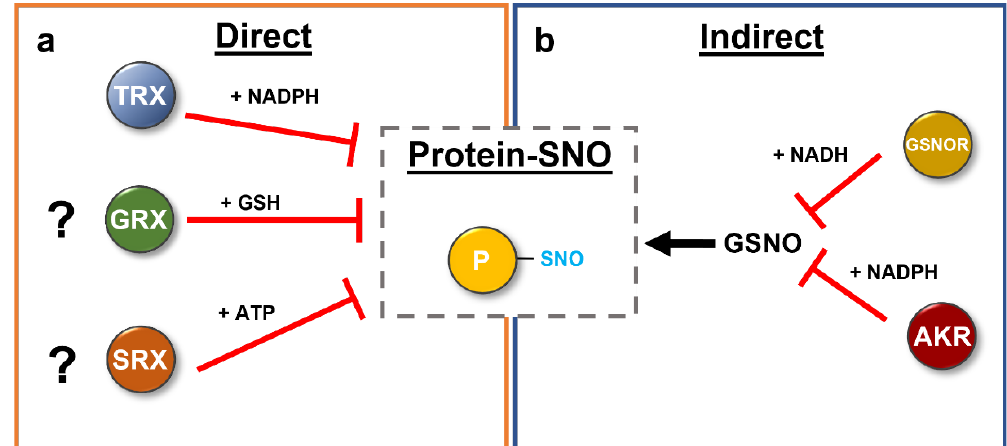
Figure 7. Direct ( a ) and indirect ( b ) denitrosation of proteins in plants. Enzymatic denitrosation systems have been reported in the literature. The thioredoxin system uses NADPH to remove the nitroso group from S -nitrosated target proteins via two distinct mechanisms. However, further studies have to show the contribution of the GRX and SRX-system in this process in plants. In contrast, the level of available NO is regulated by GSNOR and the newly identified AKR proteins, thereby modulating the S -nitrosation status of proteins indirectly. See text for further details.